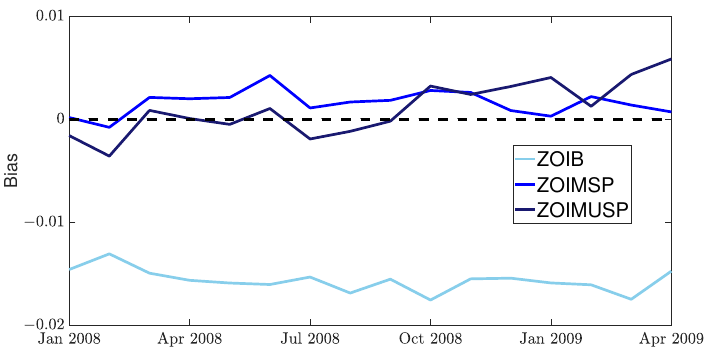
Figure 11. The empirical bias of the fitted ZOIMSP, ZOIMUSP, and benchmark ZOIB models plotted for each